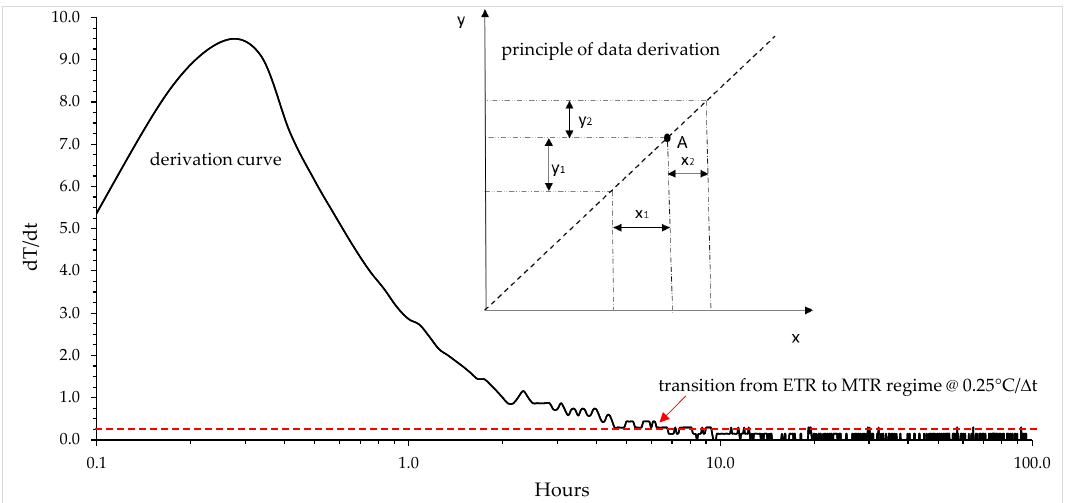
Figure 3. Determination of semi-steady-state heat flow period via the derivation curve technique.